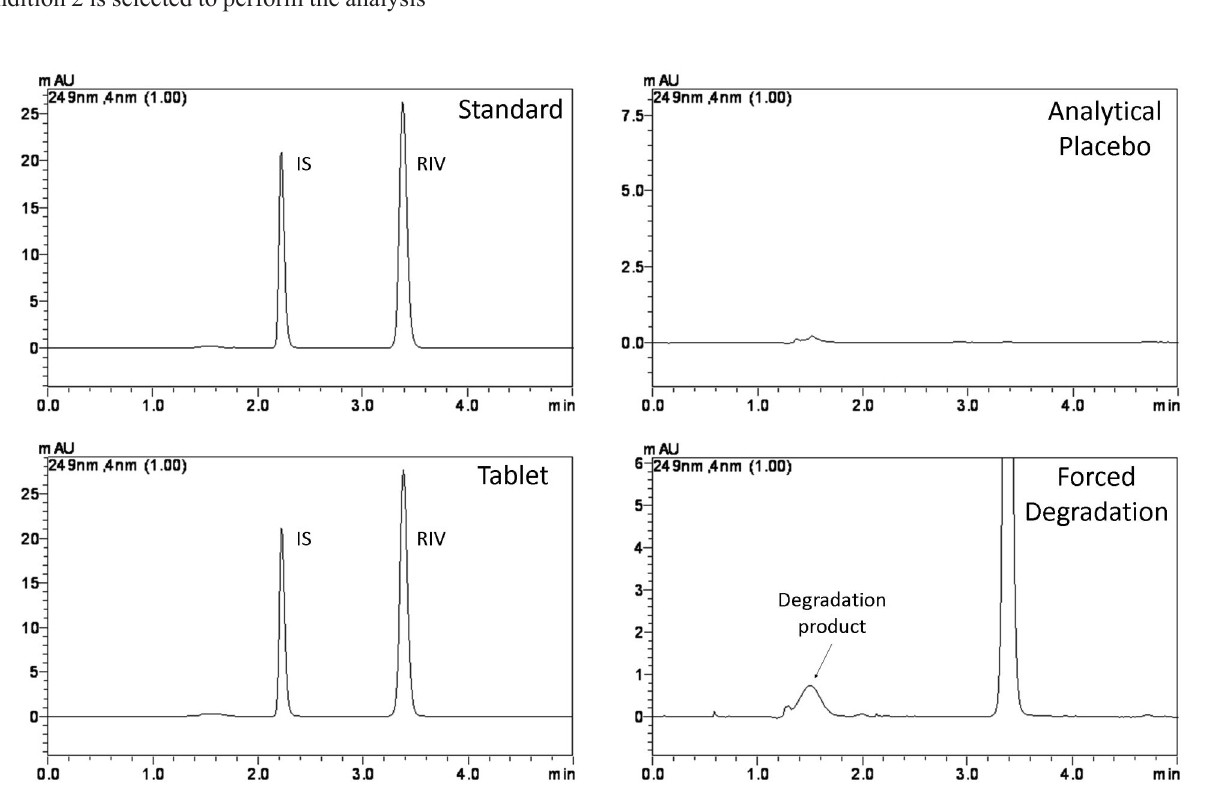
FIGURE 2 - Representative chromatograms obtained under the optimum chromatographic conditions for RIV standard, RIV tablet, analytical placebo solutions and RIV solution degraded at high